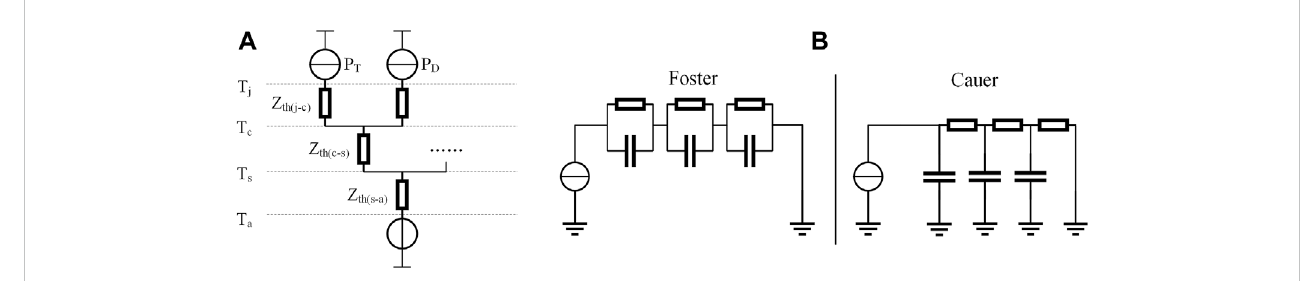
FIGURE 2 (A) Simpli fi ed thermal equivalent circuit of IGBT and diode. (B) Two thermal equivalent circuit